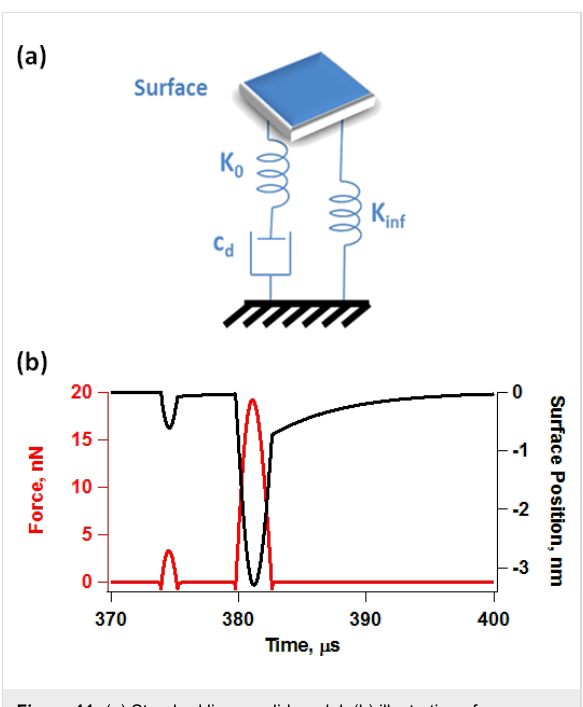
Figure 11: (a) Standard linear solid model; (b) illustration of tip–sample impact force trajectory and surface recovery for a bimodal imaging